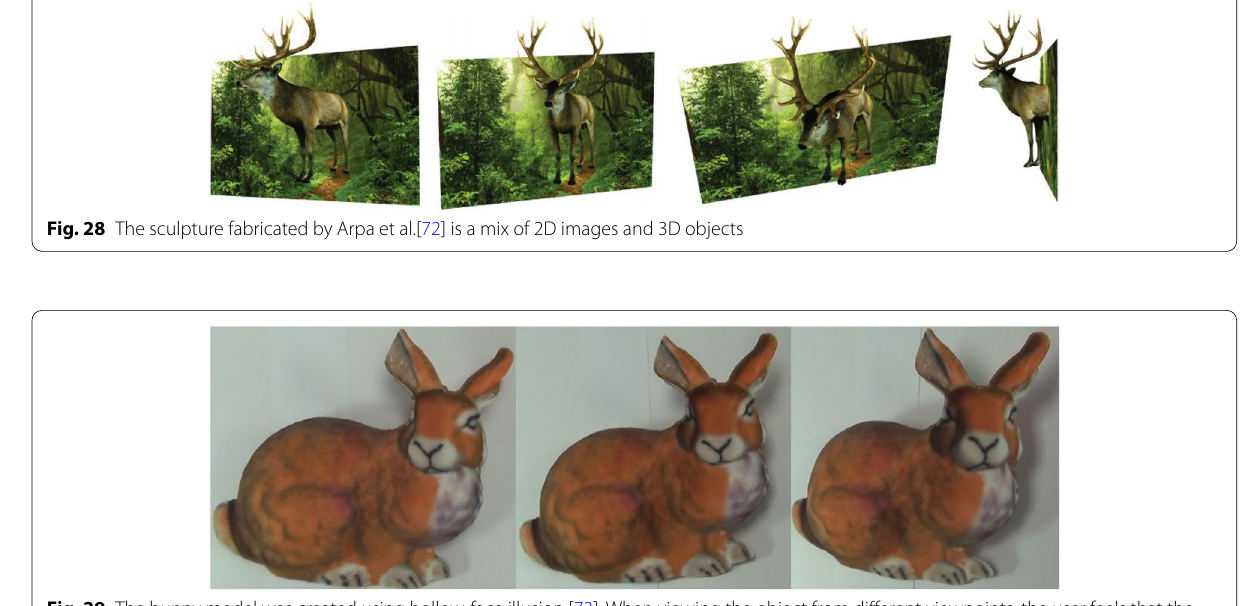
Fig. 29 The bunny model was created using hollow‑face illusion [73]. When viewing the object from different viewpoints, the user feels that the bunny’s head is